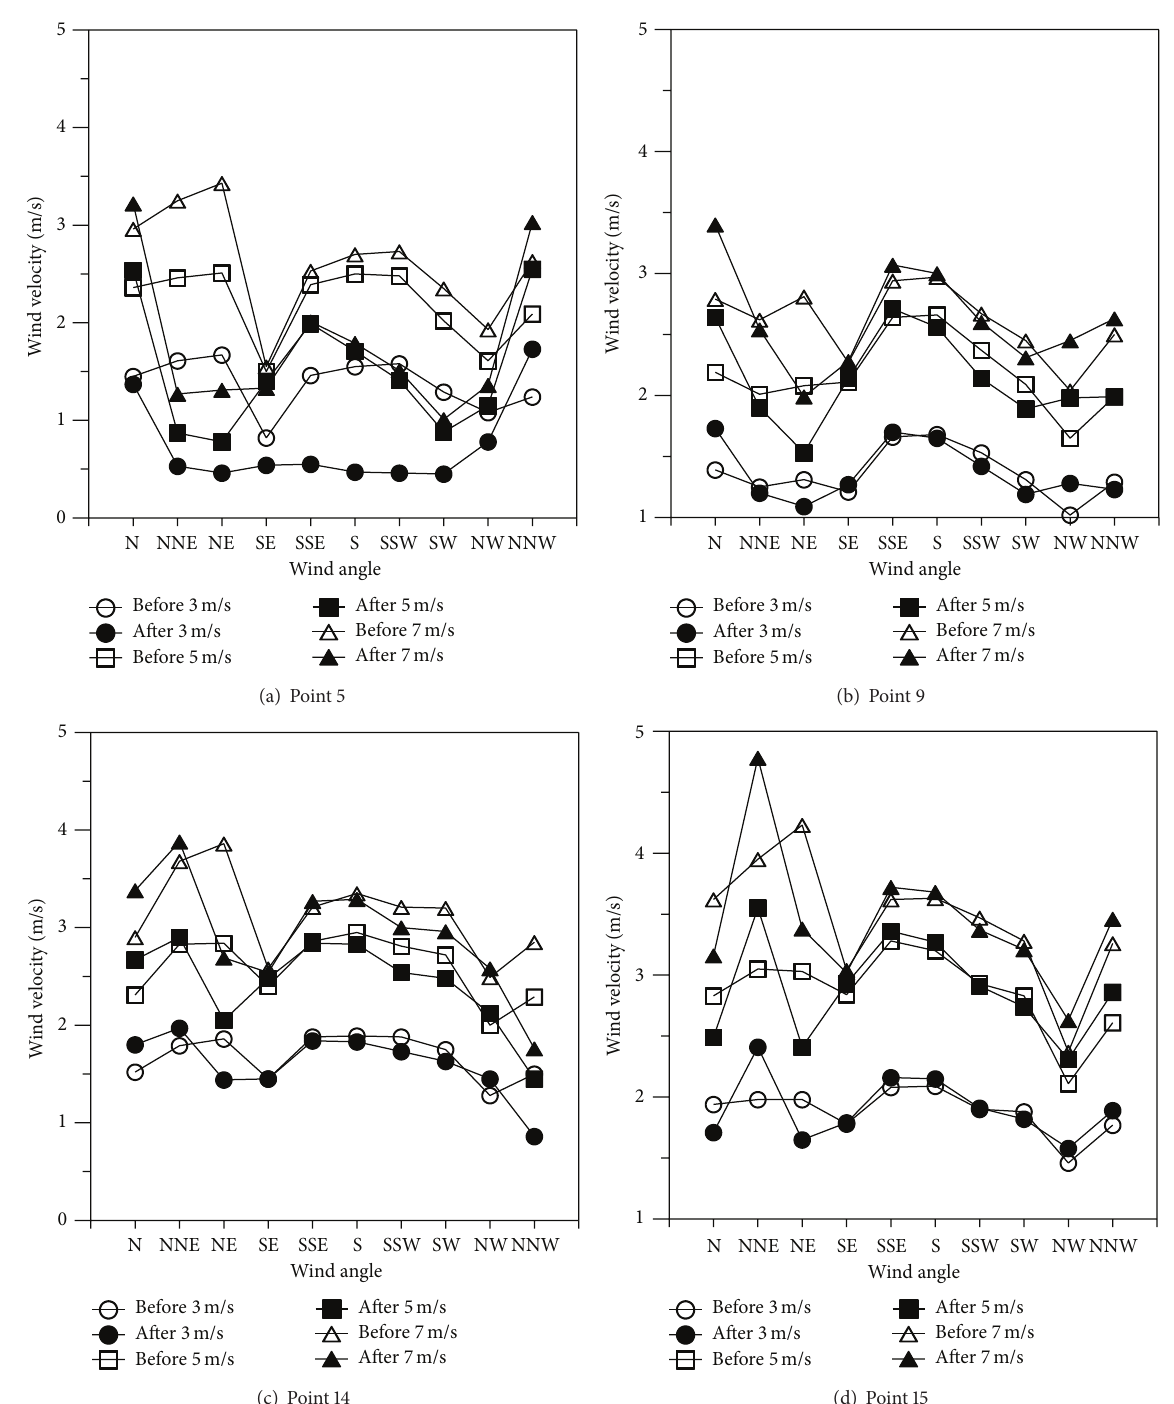
Figure 6: Distribution of wind velocities by measurement site according to wind angle changes in area to left of